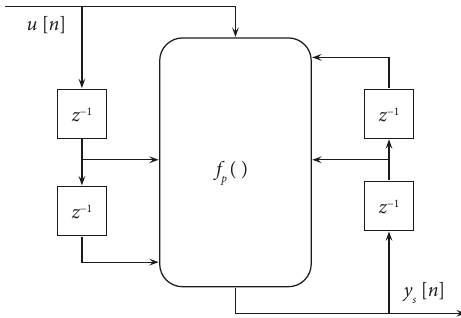
Figure 3: Neuro-fuzzy system for the plant.